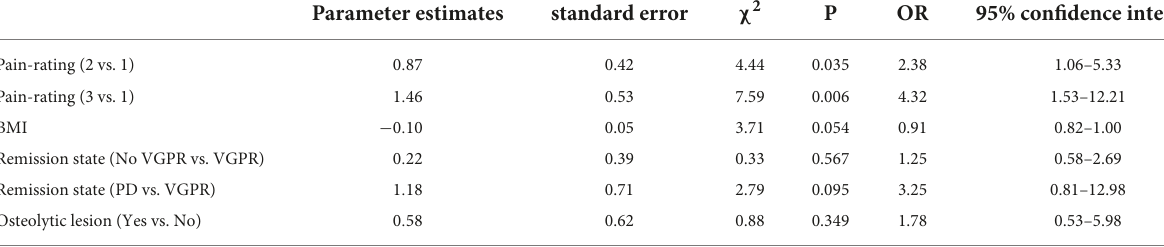
TABLE 3 Multiple logistic regression analysis of MM with depression ( n =